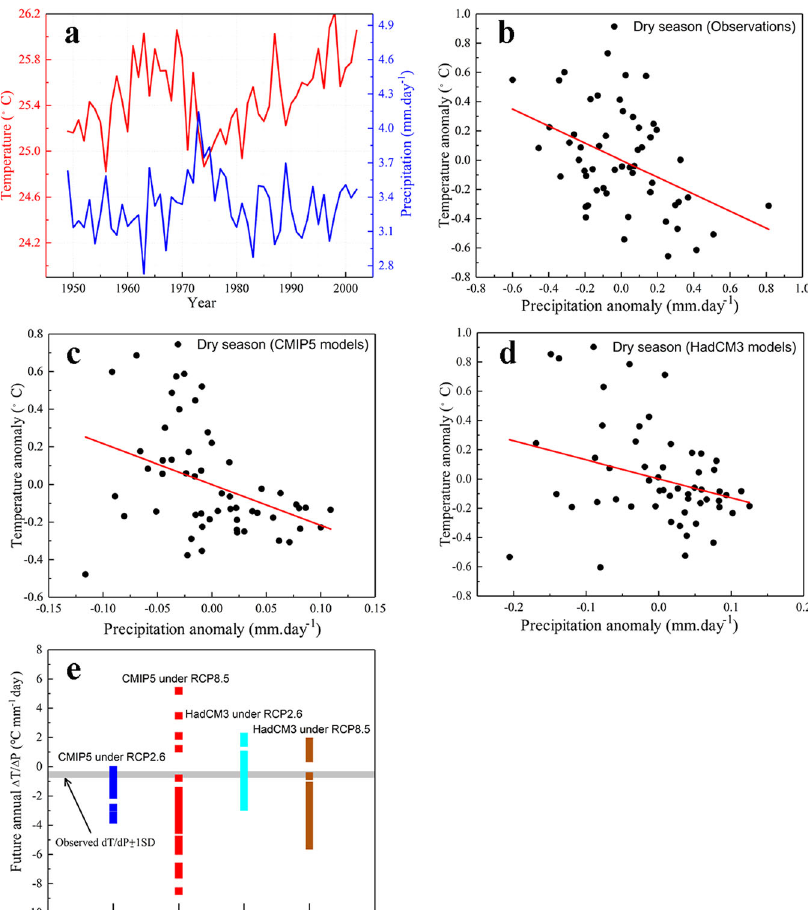
Fig. 1 Land surface air temperature – precipitation relations. a The variation of the observed dry season average temperature and the observed dry season average of daily precipitation based on the observed data from the HadCRUT4 data set during 1949 – 2002. b The linear relationship between the observed dry season average temperature anomaly and the observed dry season average precipitation anomaly ( y = ( − 0.58 ± 0.16) x , p < 0.001, R = 0.45). c, d The linear relationships between the simulated historical dry season temperature anomaly and the simulated historical dry season precipitation anomaly based on the mean outputs from the 29 CMIP5 models ( y = ( − 2.17 ± 0.7) x , p < 0.005, R = 0.4, see the relation for each model in Supplementary Fig. 3a) and the 57 HadCM3 model runs ( y = ( − 1.30 ± 0.56) x , p < 0.05 R = 0.31, see the relation for each model run in Supplementary Fig. 3b), respectively. e The uncertainties in the future annual temperature sensitivity to the precipitation ( Δ T / Δ P ) for the 86 Earth System model runs under RCP2.6 and RCP8.5 during 2006 – 2098. The grey shading represents